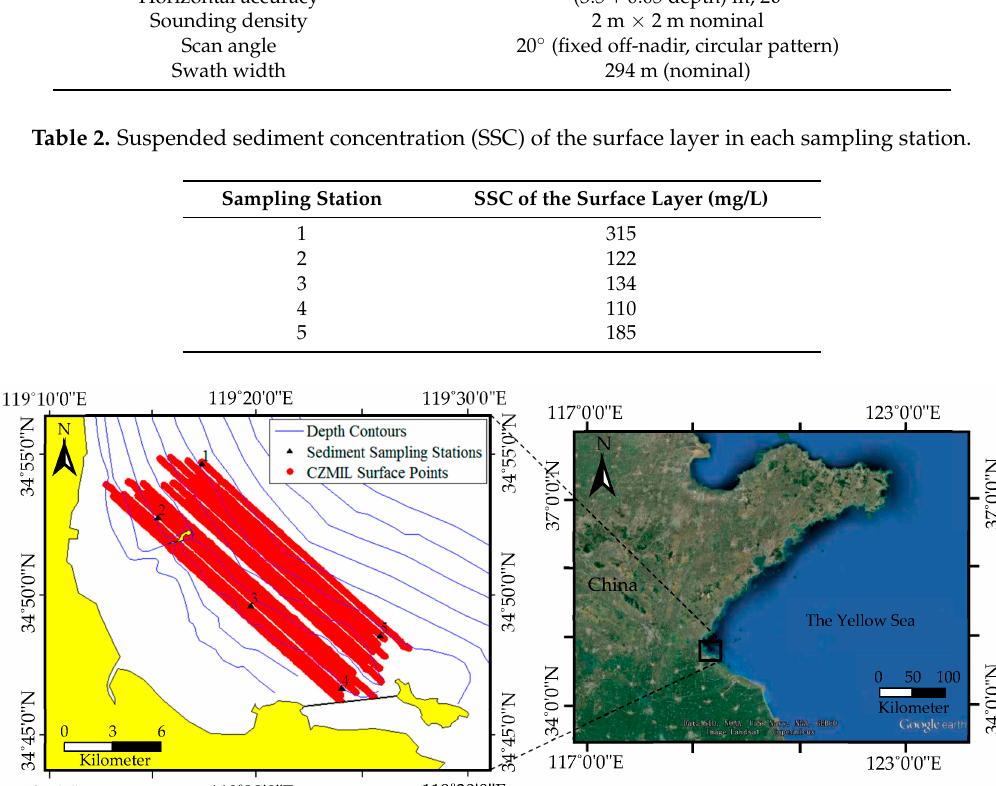
Figure 2. Locations and scopes of the different measurements. The yellow, red, and blue colors denote the land, scope of ALB measurement, and depth contours in the measured water area. The numbers 1–5 show the locations of the five SSC sampling stations .